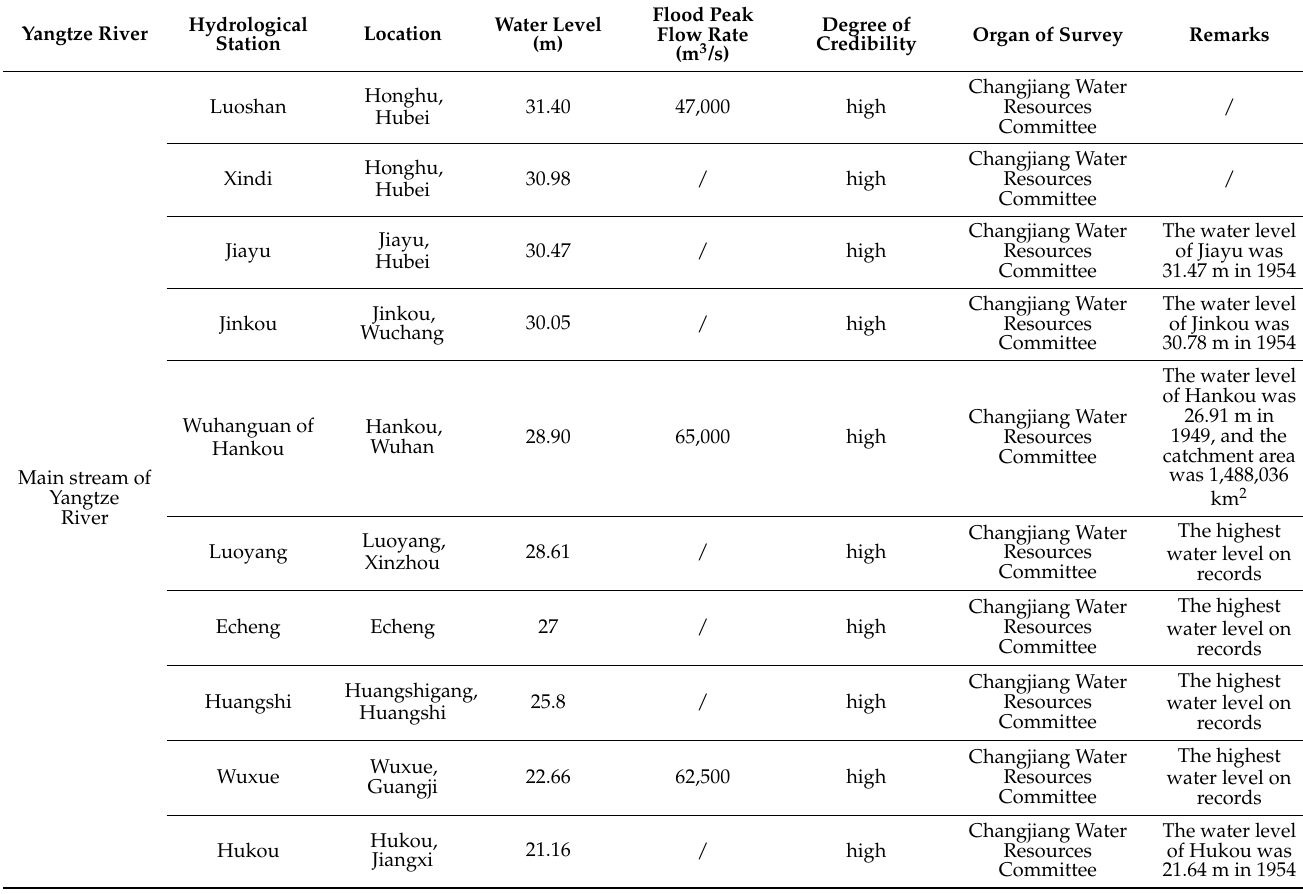
Table A2. The records of water levels and flood peak flow rates of the Yangtze River in 1849 from “ The Compilation of Survey Data of Historical Great Floods in China ”